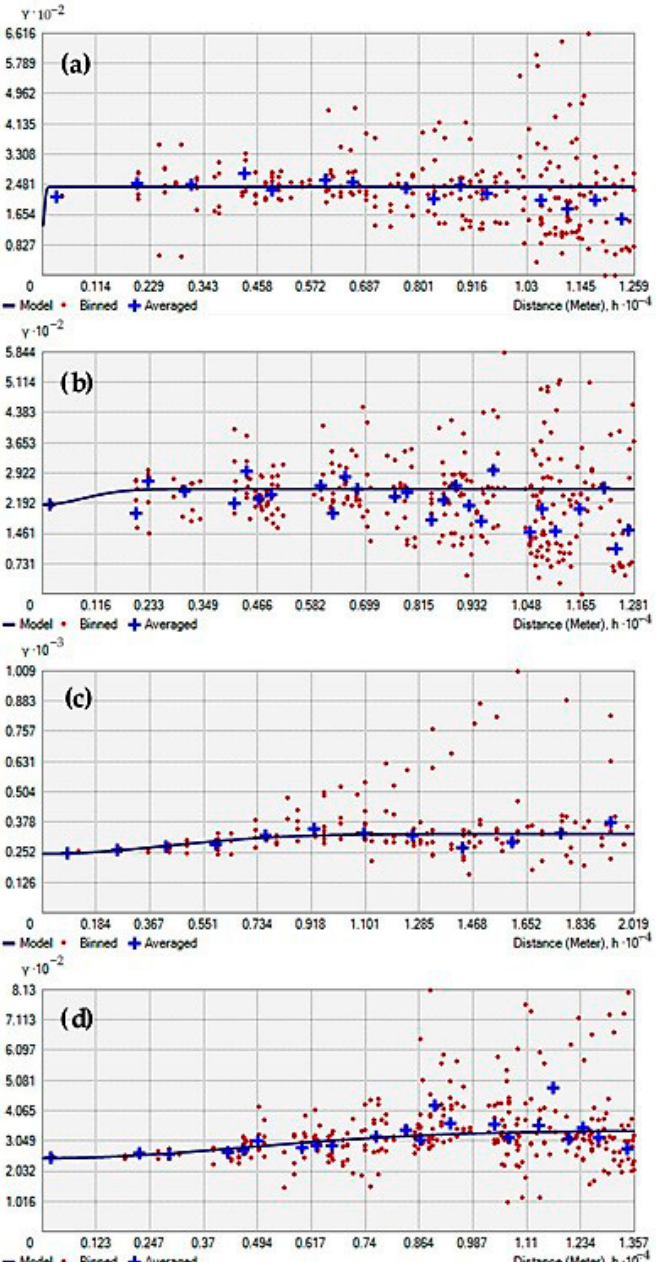
Figure 8. Empirical semivariograms and covariance models for the two forest reserves’ RF-derived residuals; ( a , c ) are the semivariogram models for NH evergreen and YM deciduous using OK analysis; ( b , d ) are the semivariogram models for NH evergreen and YM deciduous using CK analysis with a covariable of elevation. The vertical axis is the ½ variance ( γ ) and covariance (C) of the two positions as the distance increases.